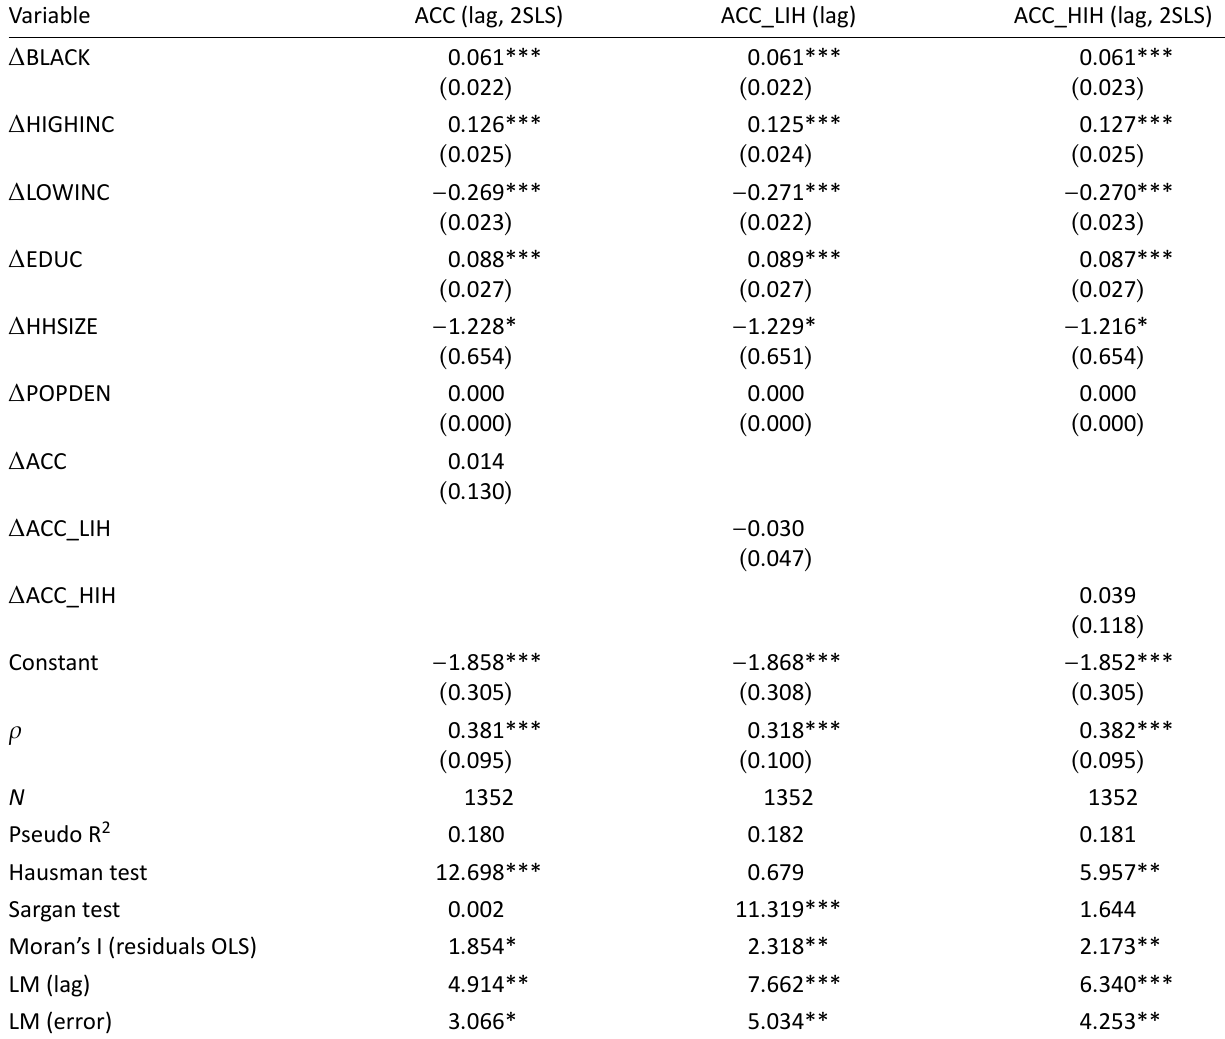
Table 2. Estimation results for changes in employment rates using spatial lag.